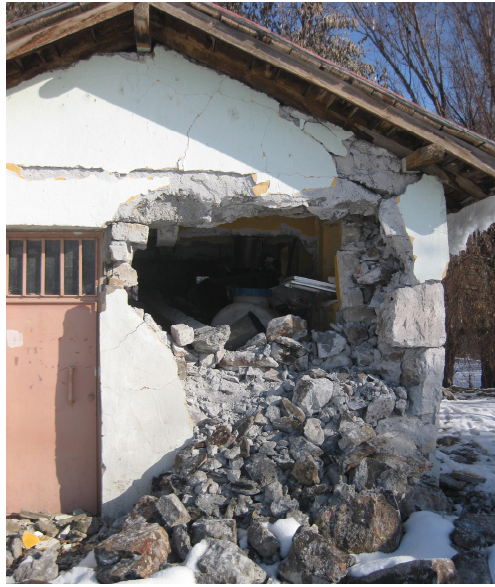
Fig. 7. Unconnected outer and inner wythes.